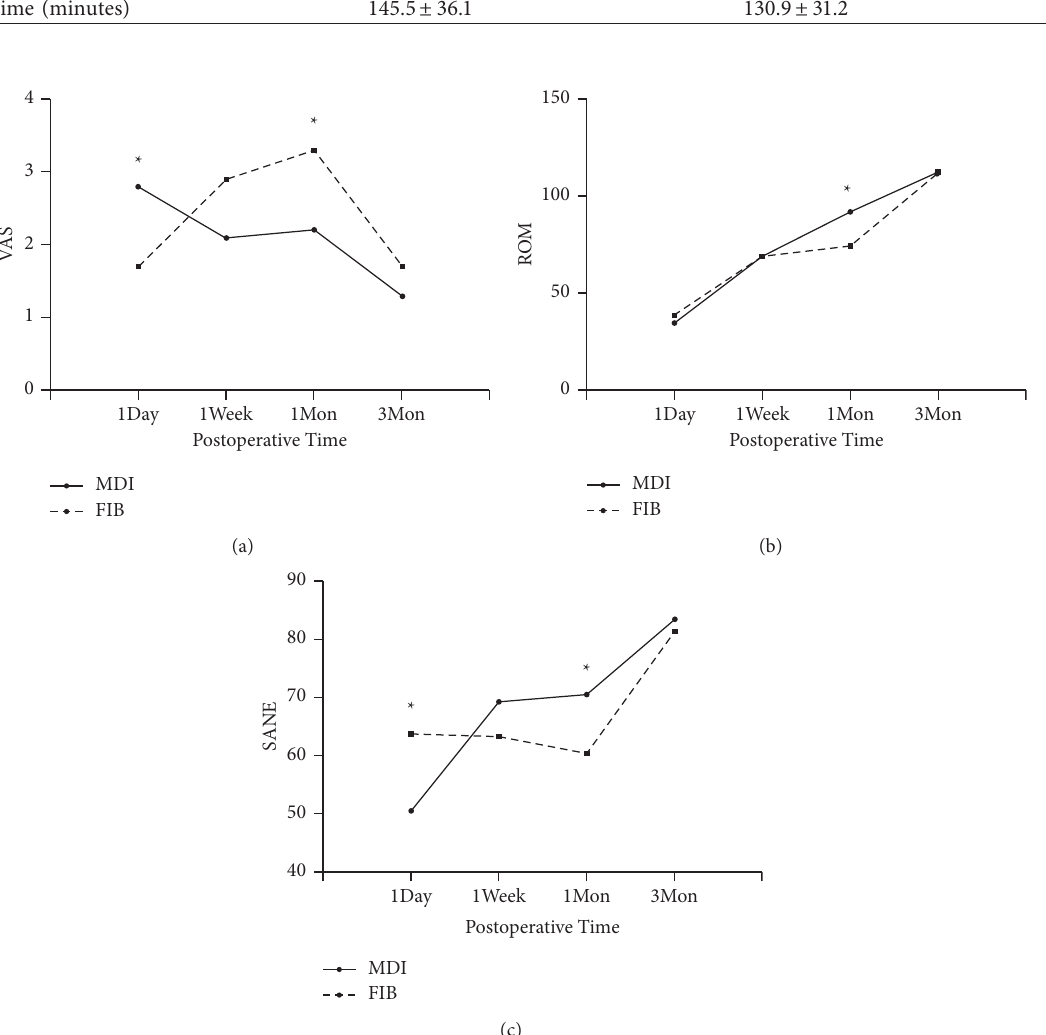
Figure 2: Changes in VAS (a), ROM of knee (b), SANE of knee (c). Data are shown as mean, ∗ p < 0 .